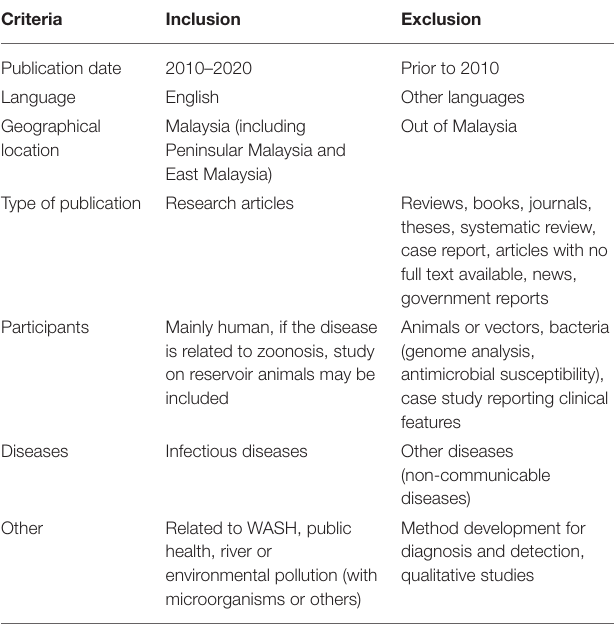
TABLE 1 | Studies were selected or excluded based on the